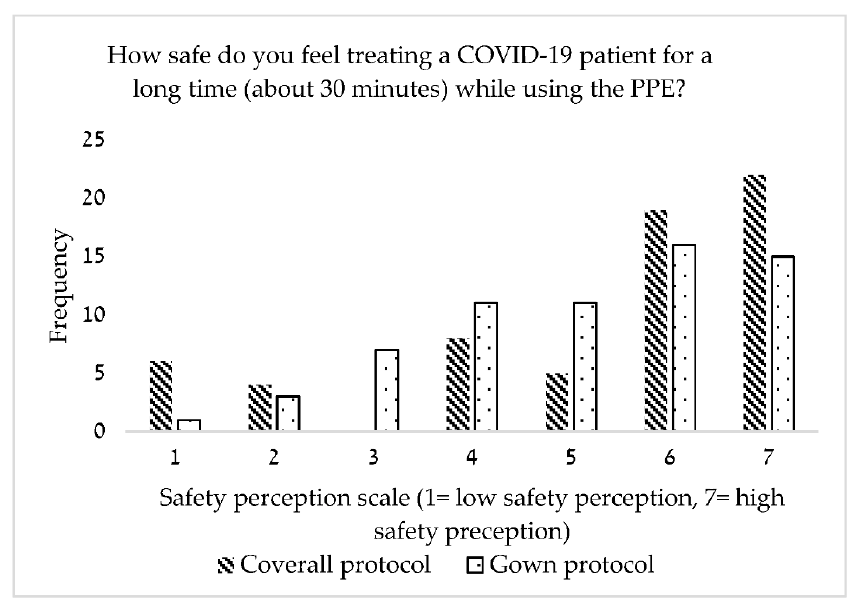
Figure 7. Safety perception rating from the perception questionnaire after using the two protocols: coverall protocol and gown